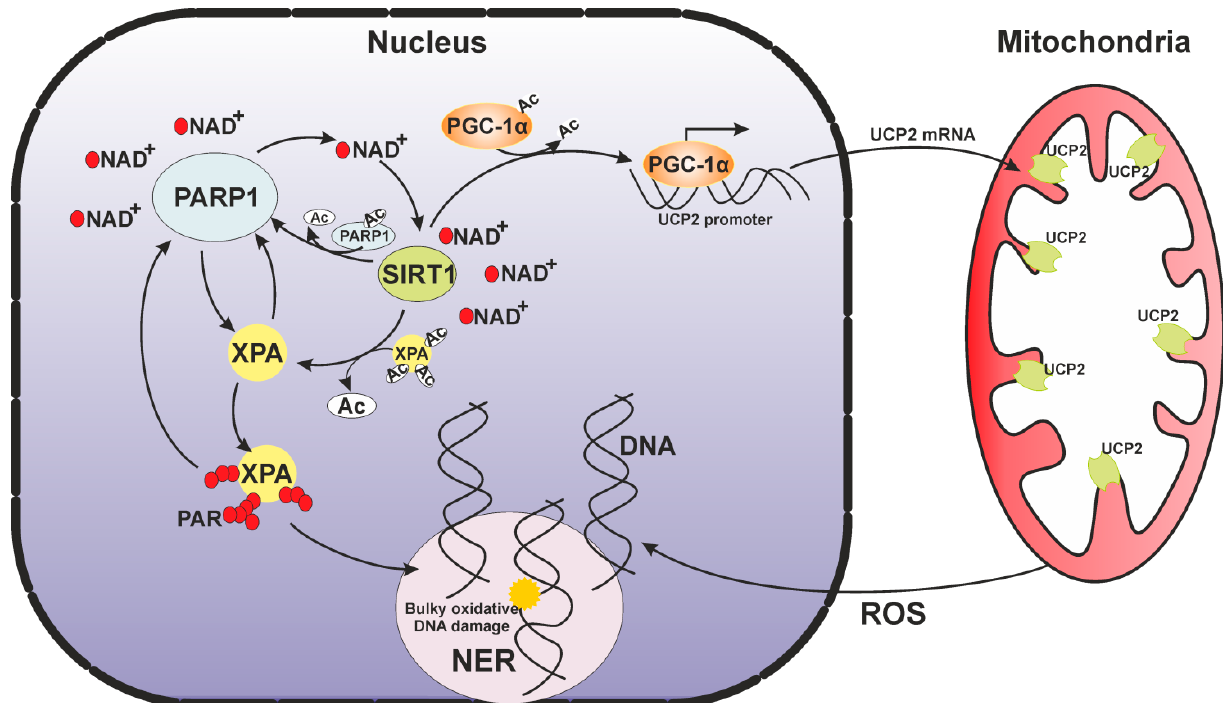
Figure 6. SIRT1–PARP1 reciprocal regulation within the nuclear–mitochondrial crosstalk occurs during normal cellular metabolism.